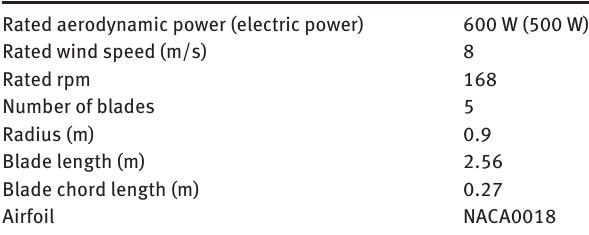
Table 1 Aerodynamic design results of VAWT.